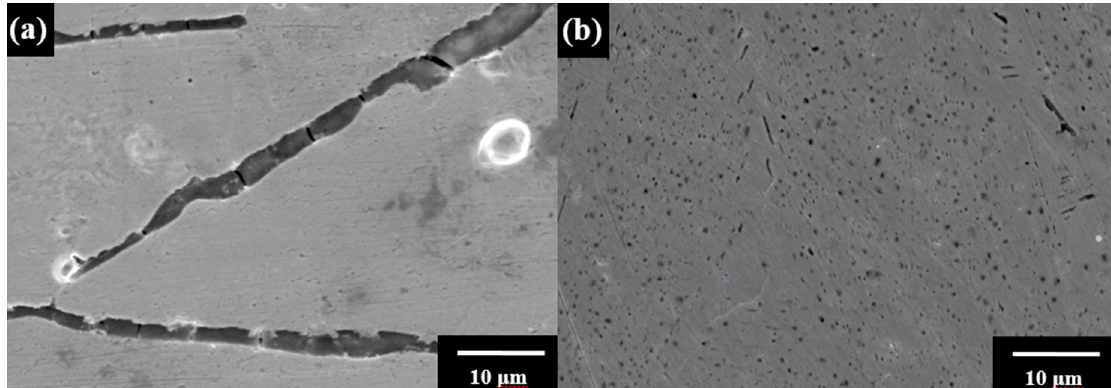
Figure 9. SEM images of Sn–8Zn–3Bi solder alloy after 170 °C 2 h exposure under air atmosphere: ( a ) SC alloy; ( b ) RC alloy.